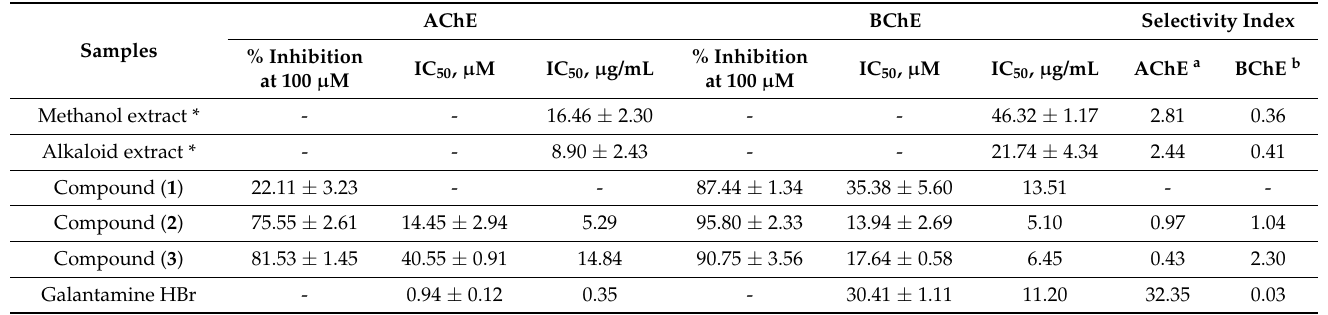
Table 2. Cholinesterase-inhibitory activity of Uncaria attenuata and its isolated compounds ( 1 – 3